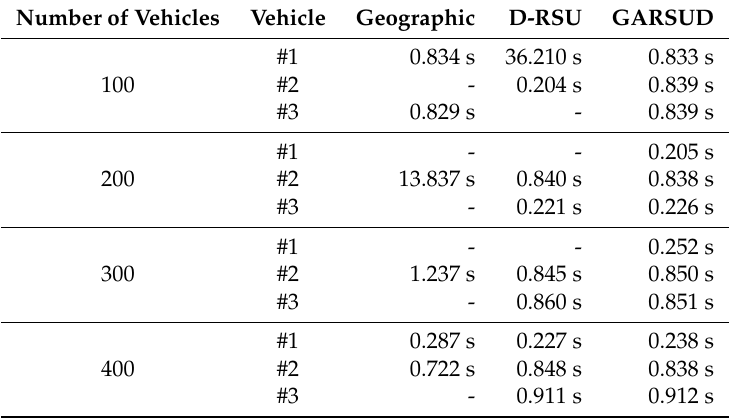
Table 3. Warning notification time (in seconds) for each warning vehicle when deploying 4 RSUs in Valencia considering a uniform traffic flow. D-RSU, Density-based Road Side Unit deployment policy.